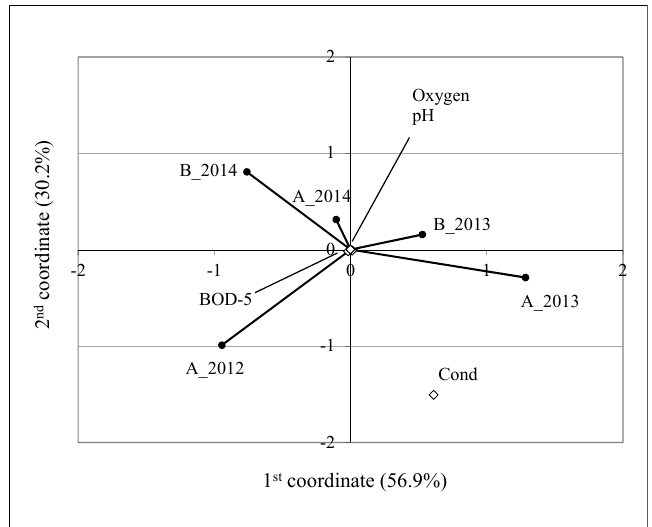
Figure 4. Position of experimental objects determined by conductivity, pH reaction, oxygen con- centration and biochemical oxygen demand in the space of the first two canonical variates and the spacing of these parameters in the dual space.